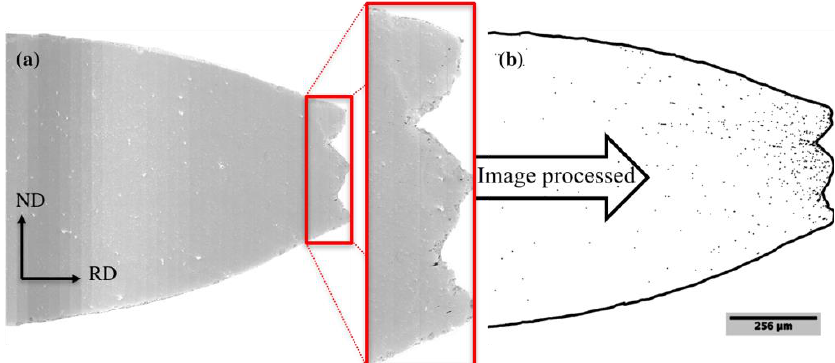
Figure 4. Roughly 1000 contiguous high-resolution SEM micrographs (each ≈ 27 × 32 µm 2 ); ( a ) after stitching all SEM micrographs and ( b ) image processed, whereby voids are magnified 50× with respect to matrix pixels for enhanced visualization.